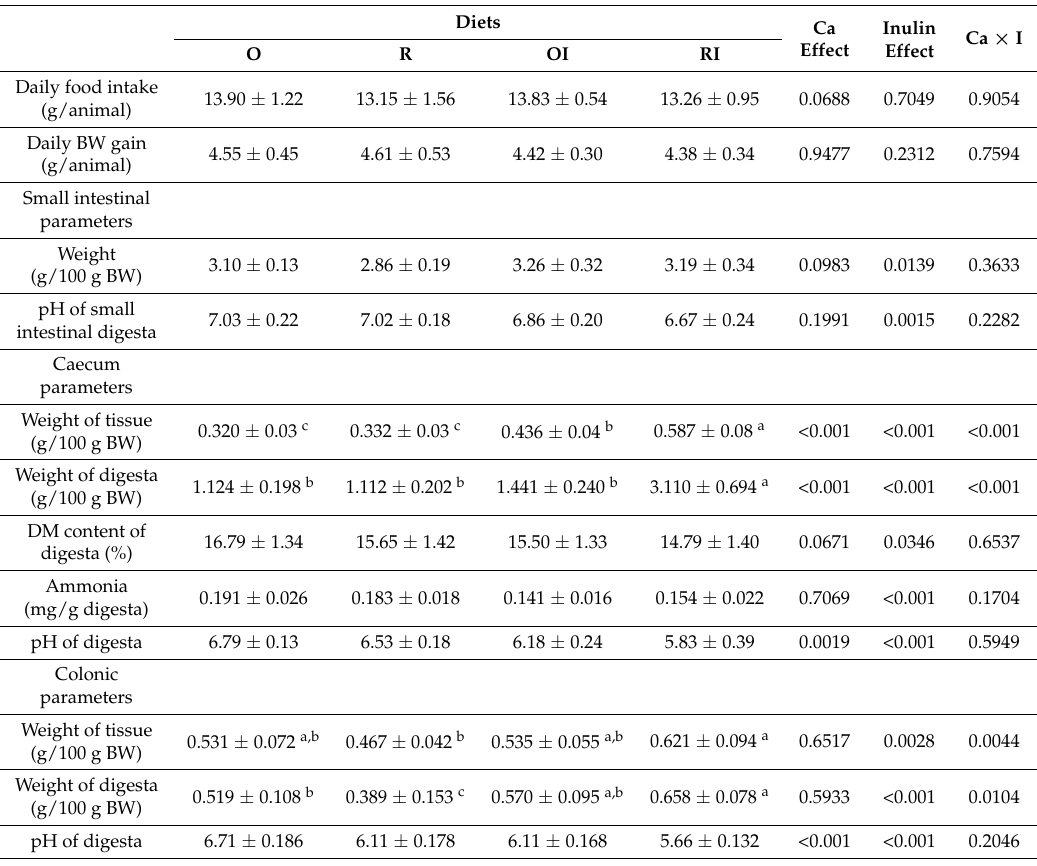
Table 2. Daily food intake, body weight (BW) gain and gastrointestinal tract parameters in rats fed experimental GF diets